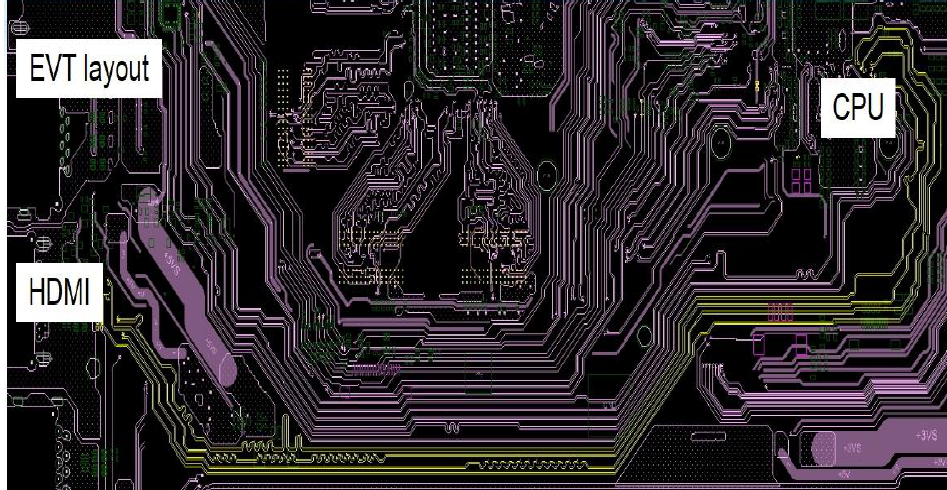
Figure 14. Printed circuit board (PCB) HDMI wiring diagram .